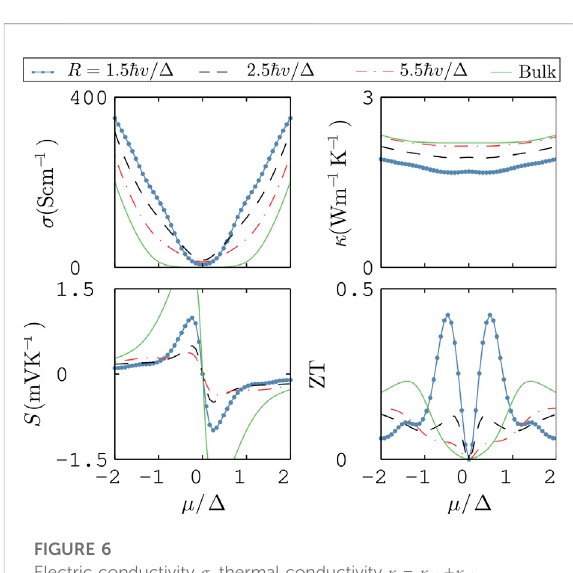
FIGURE 6 Electric conductivity σ , thermal conductivity κ = κ ph + κ el , Seebeck coef fi cient S and fi gure of merit ZT as a function of the chemical potential at 300 K. Results for two values of the NW radius are shown and compared to bulk PbTe.